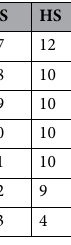
Table 1. Sample numbers (see Supplementary Table 1 for ID and crown-rump length). CS Carnegie stage, HS histological section, PCX-CT phase-contrast CT.